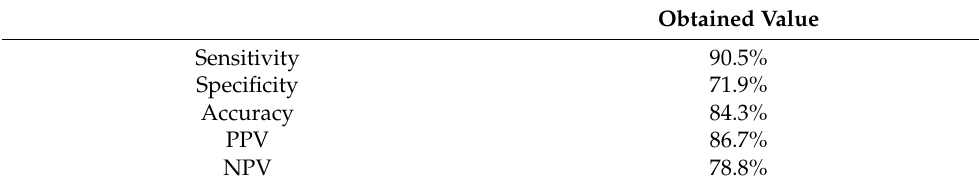
Table 4. Characteristics of 99m Tc-EDDA/HYNIC-TOC SRS in our